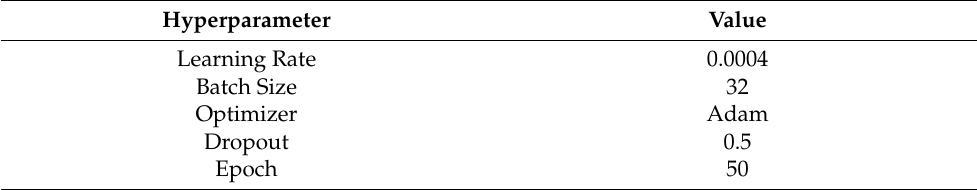
Table 3. Hyperparameters specified for training.